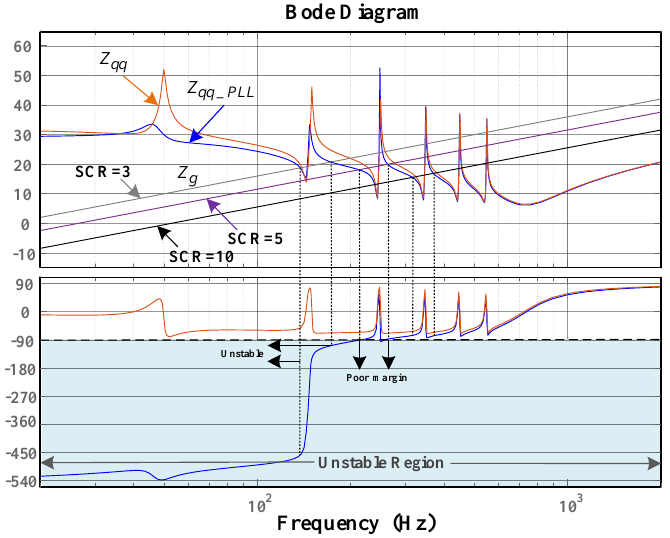
Figure 3. Bode plot of the inverter impedance with and without considering